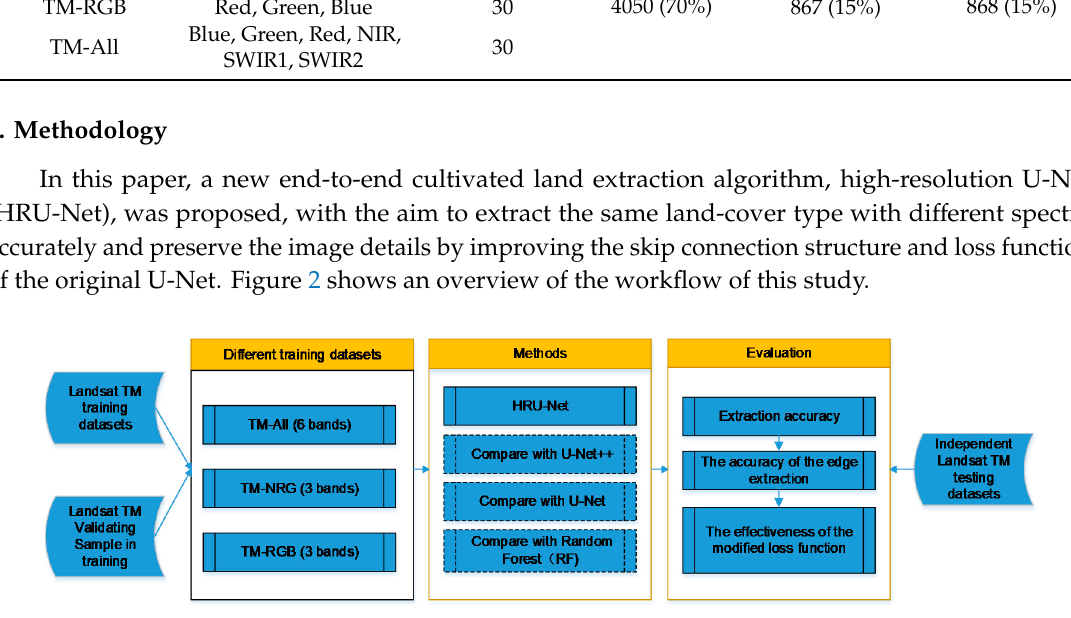
Figure 2. Overview of the performance evaluation framework. High-resolution U-Net (HRU-Net).